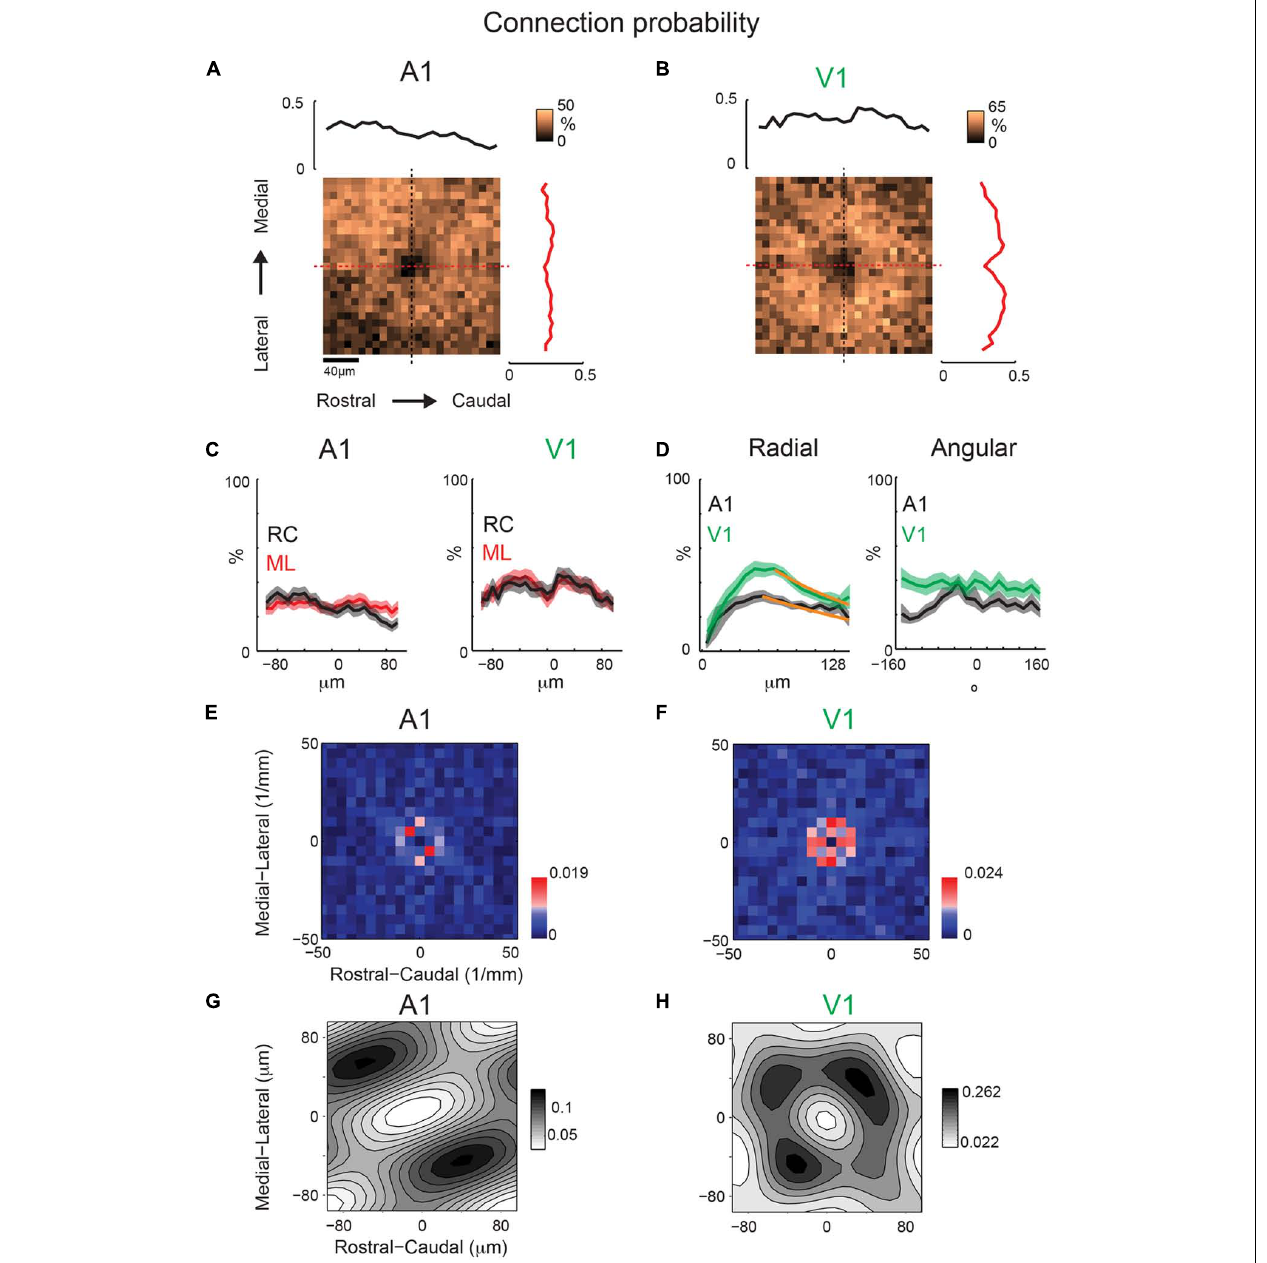
FIGURE 10 | Mean inhibitory connection probability maps from a population of neurons recorded at 40 × show spatial symmetry and anisotropic spatial periodicity in ML (isofrequency) direction. Mean maps from a population of A1 ( A ; N = 31) and V1 ( B ; N = 20) recorded neurons demonstrating relatively symmetric profile of inhibitory inputs in both A1 and V1. Plots above and to the right of the mean map indicate the marginal profile along the ML (isofrequency) and RC (tonotopic) directions, respectively. (C) ML and RC marginals from (A,B) overlaid for A1 (left) and V1 (right). (D) Mean map polar marginals where the radial profile (left) is a plot of the average of annuli around the cell-center against radial distance from the cell-center, and the angular profile (right) plots the average of